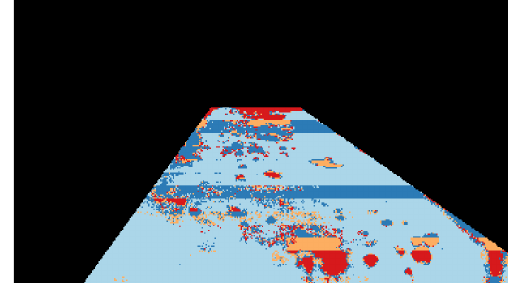
Figure 6. Example of found clusters in the clinker bed